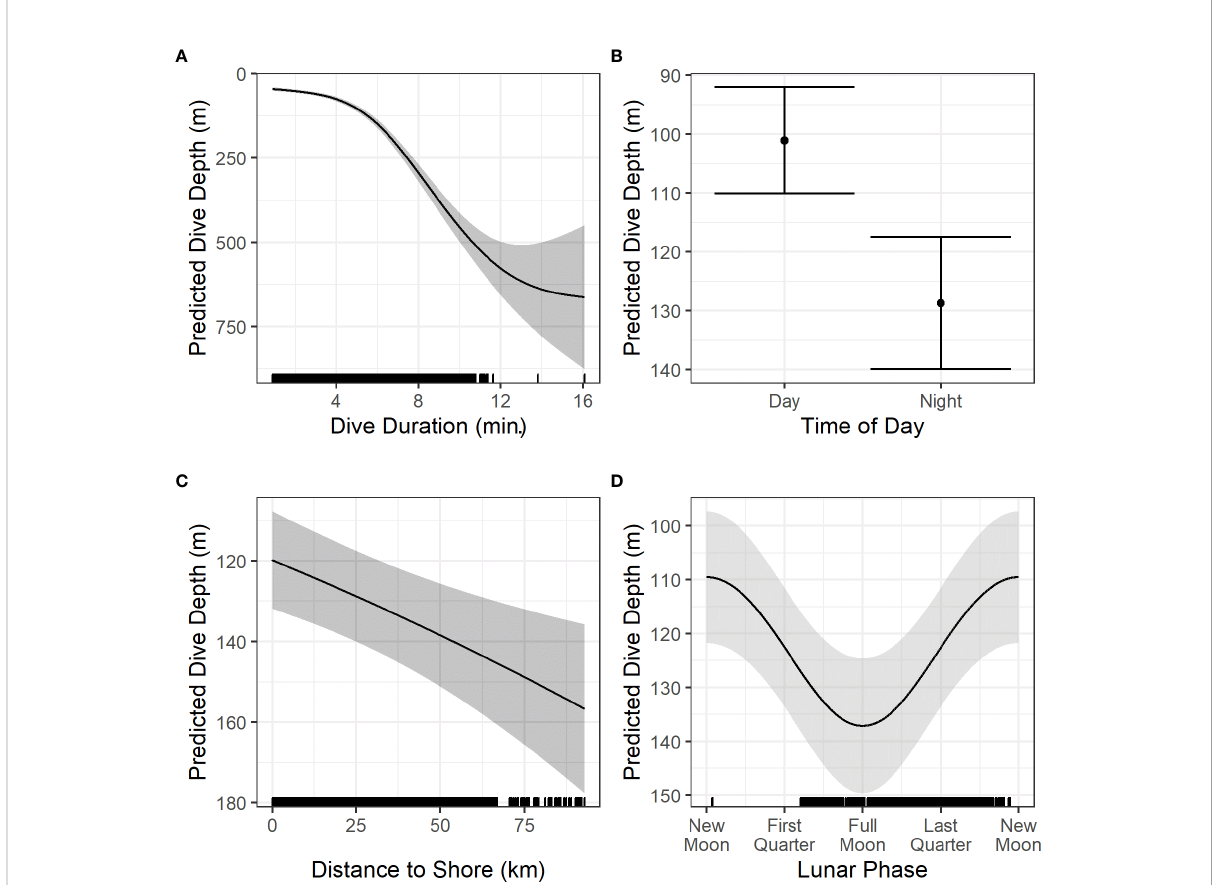
FIGURE 6 Prediction plots of signi fi cant variables (A – D) from the models of dive depth. Solid black lines/dots represent mean predicted values with shaded areas/error bars representing the 95% CI. Hash marks along the x-axis shows the spread of data. For the creation of these plots, values for other predictors in each model were set at the median or modal value as follows: time of day = night, Chl residuals = -0.008, SST = 15.81, distance to shore = 24.68 km, sine of lunar phase = -0.736, cosine of lunar phase = -0.435, dive duration = 5.6 min. Chl, Chlorophyll- a (mg m-3); SST, Sea Surface Temperature